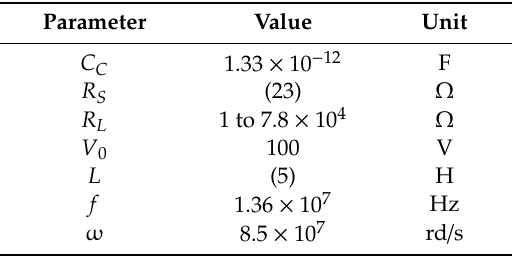
Table 3. Parameters of circuit model for power and efficiency analysis.